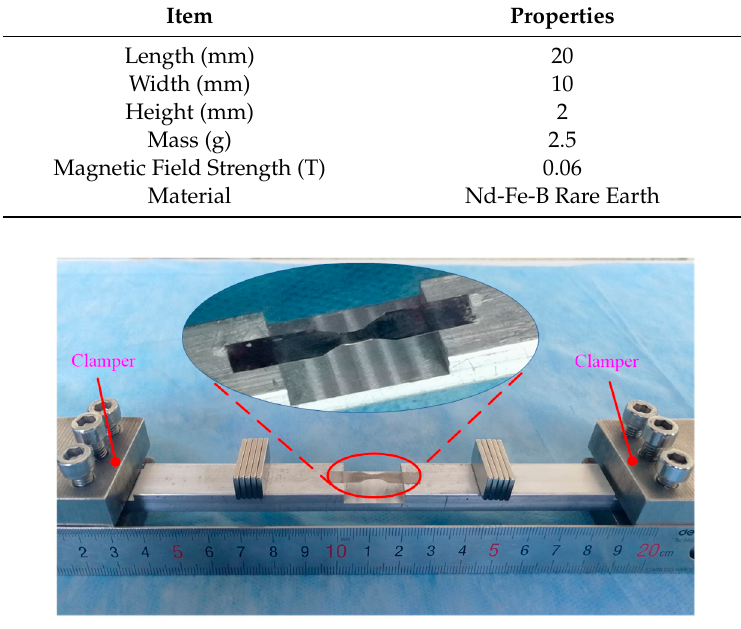
Figure 2. Prototype of the proposed HSMS.